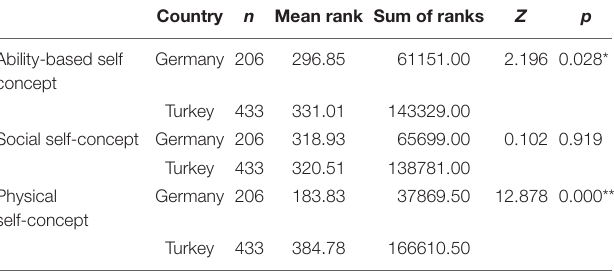
Country n Mean rank Sum of ranks